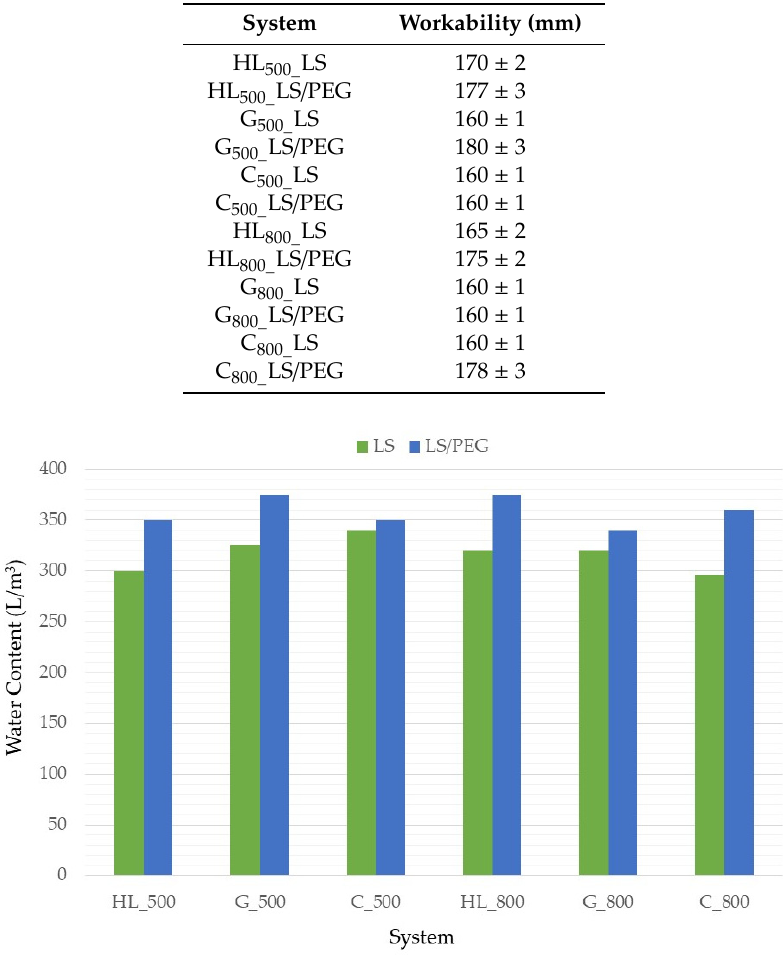
Figure 3. Variation of the water content for each mortar composition with the addition of the phase change material change material (PCM).